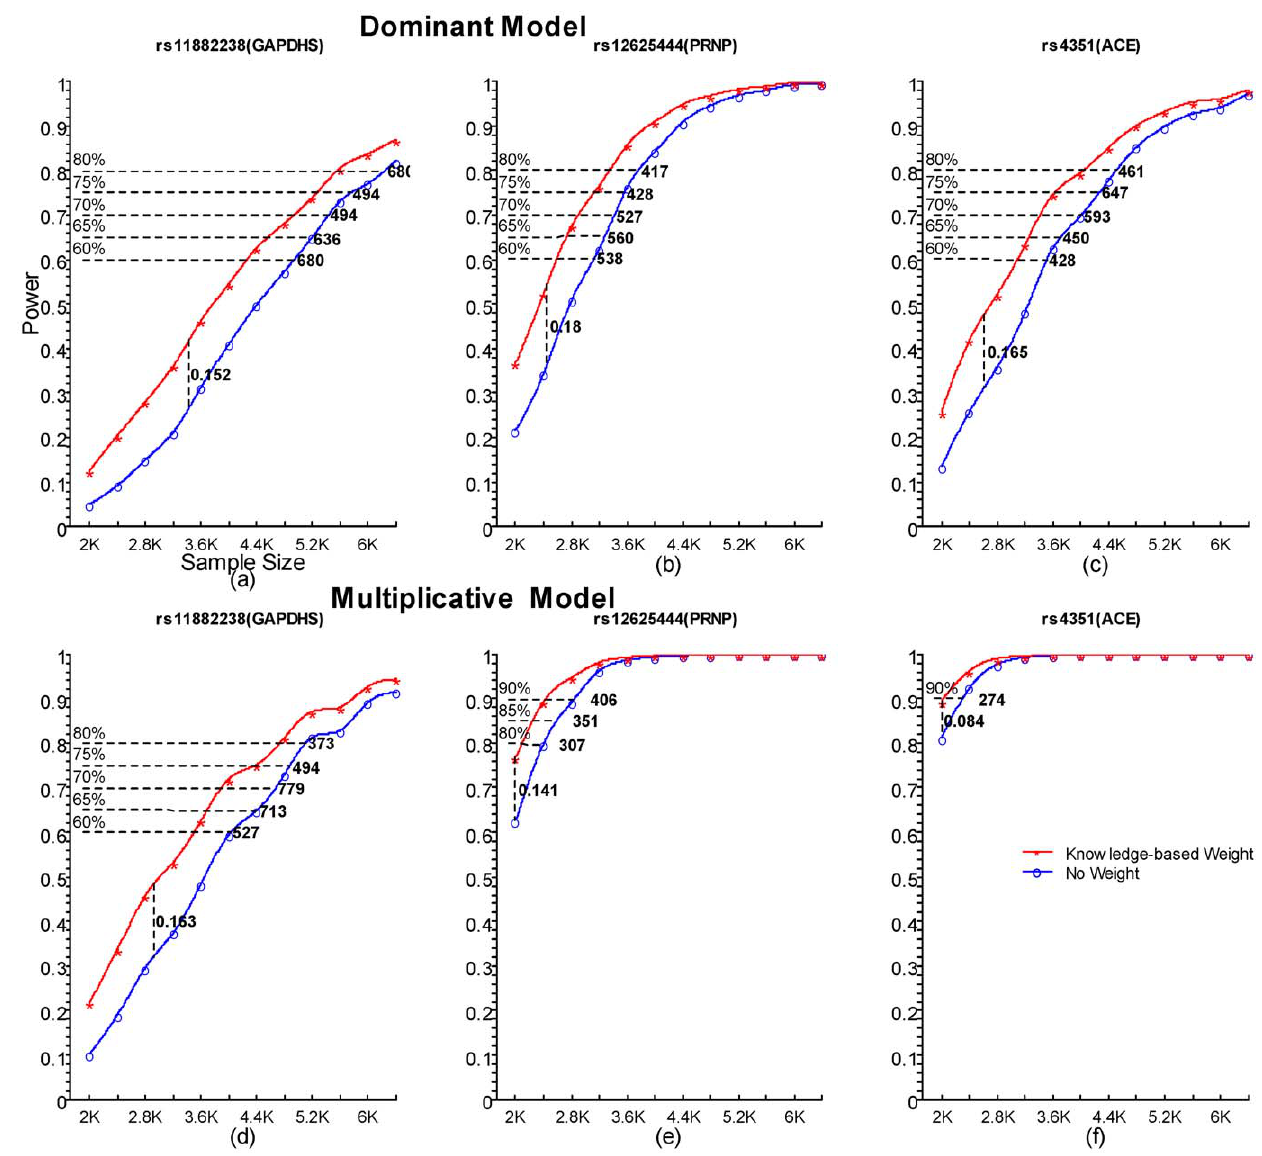
Figure 2. Comparison of power between the weighted and non-weighted basic allelic association tests in the simulated dataset when sample size varies. Plots a), b) and c) show the power identifying rs11882238, rs12625444 and rs4351 under the dominant model, respectively. Meanwhile, Plots d), e) and f) represent the power under multiplicative mode for the three SNPs. All of the three SNPs are assumed to be in the strong-clue set. The sample size increases from 2000 to 6400 by 400 with equal number of cases and controls. On the plots 1K denotes 1000 subjects. The curves are smoothed by the natural cubic spline method. The maximal power difference between these curves is labeled by a dashed vertical line on each plot. The dashed horizontal line indicates the saved whole-genome sample size by our knowledge-based weight approach for a given power compared with the original statistical test.